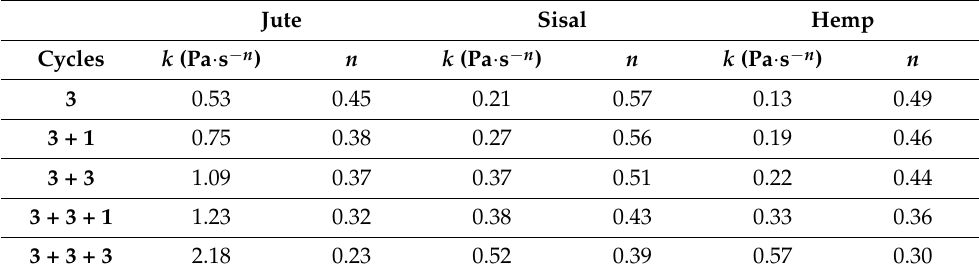
Table A5. Ostwald–de Waele fitting parameters for enzymatic MCNF (80 mg/kg).